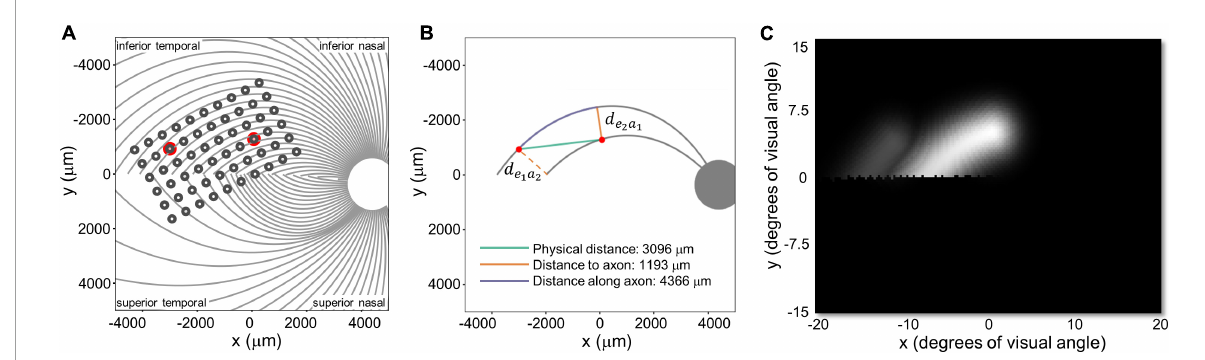
FIGURE5 (A) Estimated position of the electrode array on the retinal surface for S1 (replotted from Figure 4A ). (B) Examples of distance to and along axon fibers, d e and d e refer to the shortest distance from an electrode to the axonal bundle closest to fellow electrode. (C) Predicted percept for 1 a 2 2 a 1 the two electrodes shown in panels (A,B) . Note that all panels are in visual space coordinates, with the upper visual field at the top of the